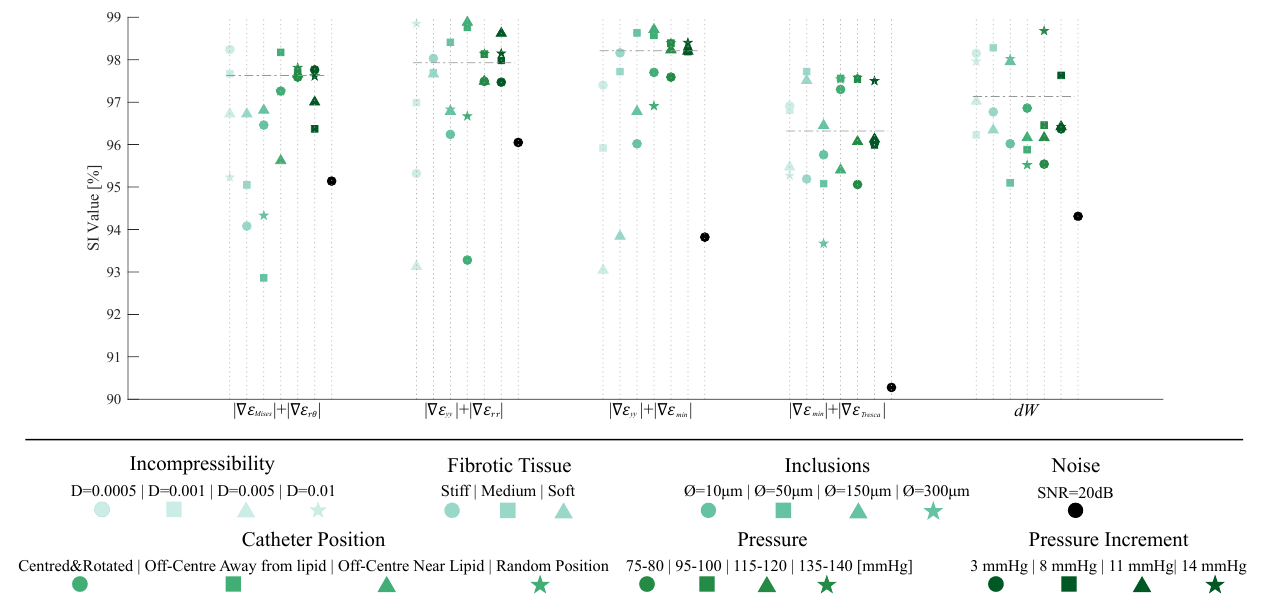
Figure 10. Graphic summary of the influence of incompressibility, changing fibrotic tissues, addition of inclusions, different catheter positions, different pressures and pressure increments, and noise addition on the segmentation process. The considered SGVs are |(cid:53) ε Mises | + |(cid:53) ε r θ | , (cid:12) (cid:12) (cid:12) (cid:53) ε yy (cid:12) + |(cid:53) ε min | , |(cid:53) ε min | + |(cid:53) ε Tresca | , and dW . Each SGV has different variables to analyze, divided by colors. Each plaque- or IVUS-related variable had different cases that were differentiated by shape